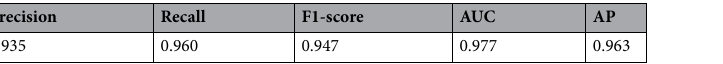
Table 1. Binary detection metrics of mandibular fractures on panoramic radiographs. AUC area under the curve receiver operating characteristics curve, AP precision-recall curve.